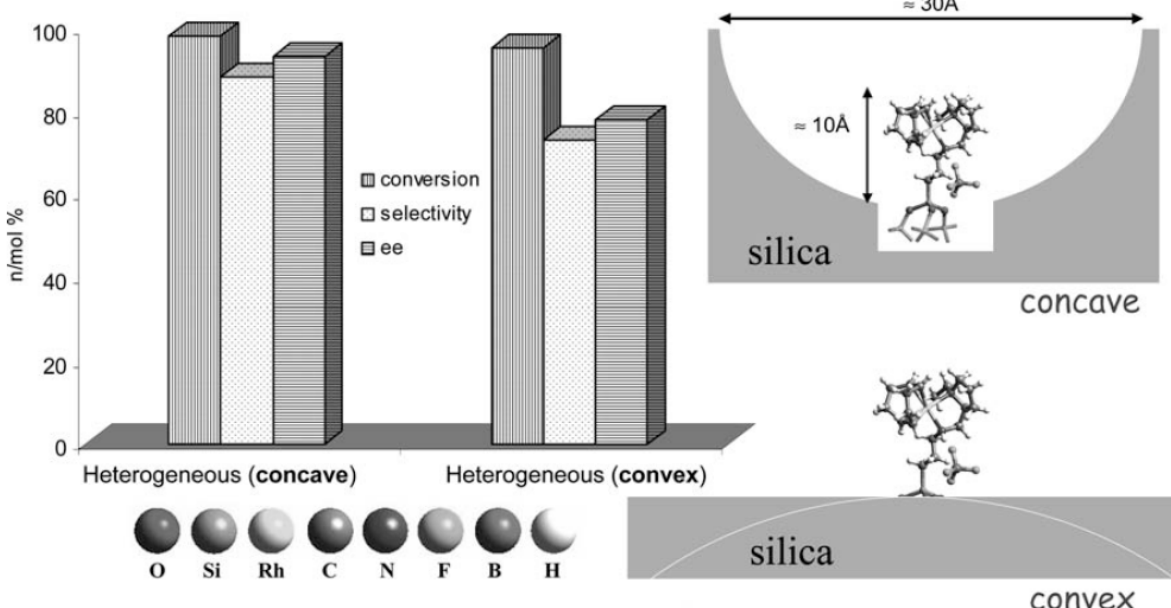
Figure 14. Sketch (to scale) of the influence of the confinement effect on the catalytic behaviour. The selectivity and e.e. value in the hydrogenation of E -( α )-phenylcinnamic acid obtained over the asymmetric Rh catalyst is higher in the spatially constrained system (concave surface) than in the less constrained one (convex surface). From Ref. [6], reproduced with kind permission of Springer Science and Business